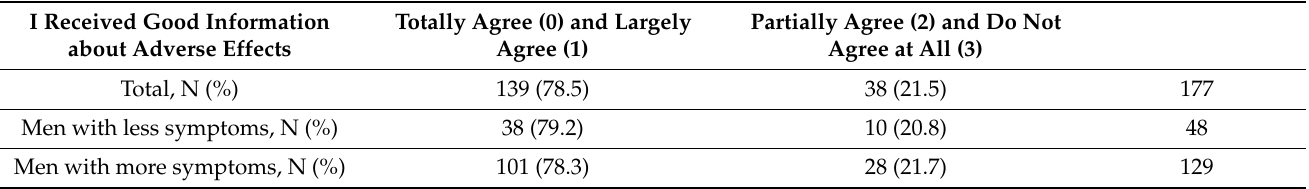
Table 4. Descriptive statistics on the item “I received good information about adverse effects” stratified on men who reported less and more symptoms after treatment (defined as the difference between EPIC score at follow-up and